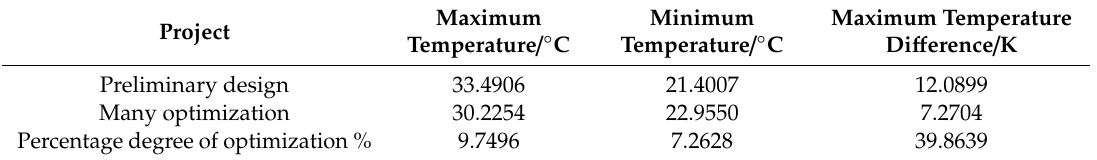
Table 6. Comparison of results before and after optimization of the air-cooling system